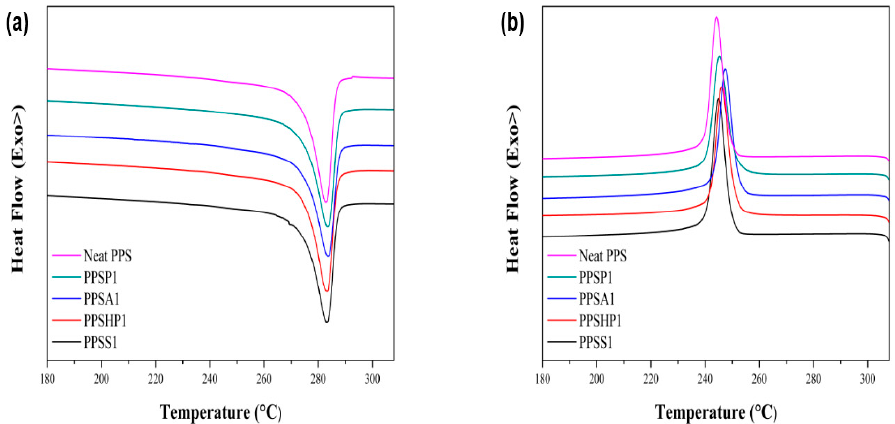
Figure 5. Differential Scanning Calorimetry ( a ) melting curve and ( b ) cooling curve for 10 °C/min heating rate of the PPS/MWCNTs composites. Table 1. DSC thermal data of the PPS/MWCNTs composites.